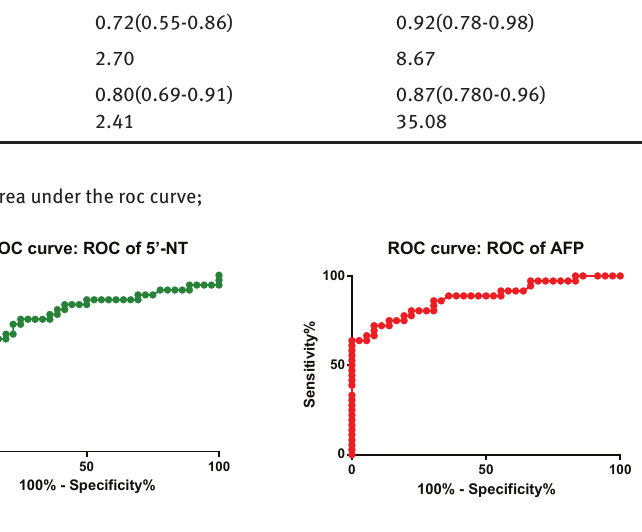
Figure 2: The ROC curve of serum AFU, 5’-NT and AFP for hepatocellular carcinoma